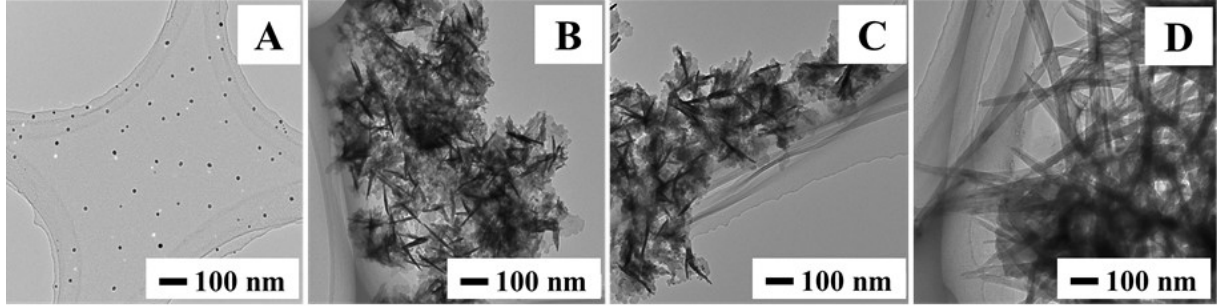
Figure 1. Transmission electron microscopy (TEM) images of nanoparticles synthesized with Cu:Fe metallic feeding ratios of ( A ) 100:0; ( B ) 70:30; ( C ) 50:50; and ( D )